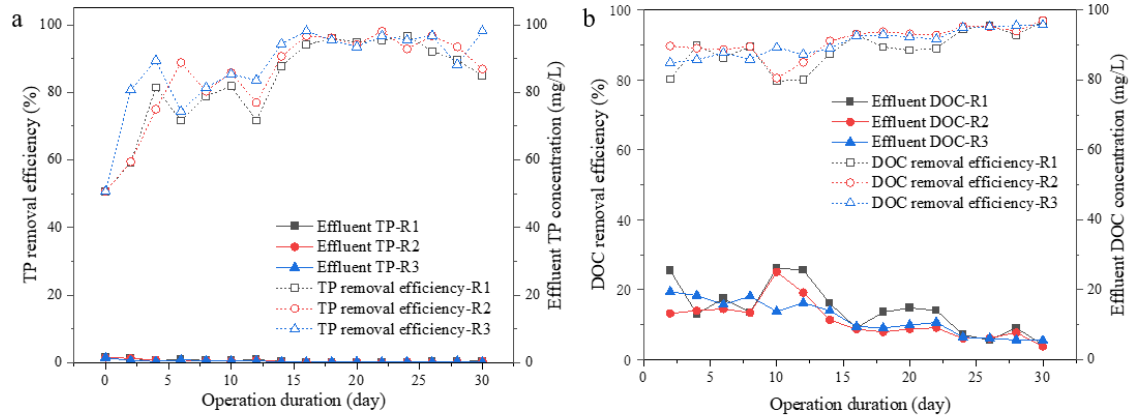
Figure 5. Effluent TP and DOC concentration or removal efficiency. Effluent TP and TP removal efficiency ( a ); effluent DOC and DOC removal efficiency ( b ).